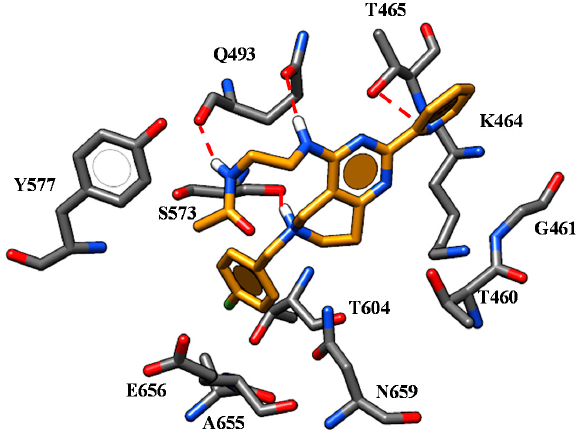
Figure 11. Docking mode of 50 (C atom; orange) within the CFTR h NBD1 domain. The most important residues are residues are labelled.